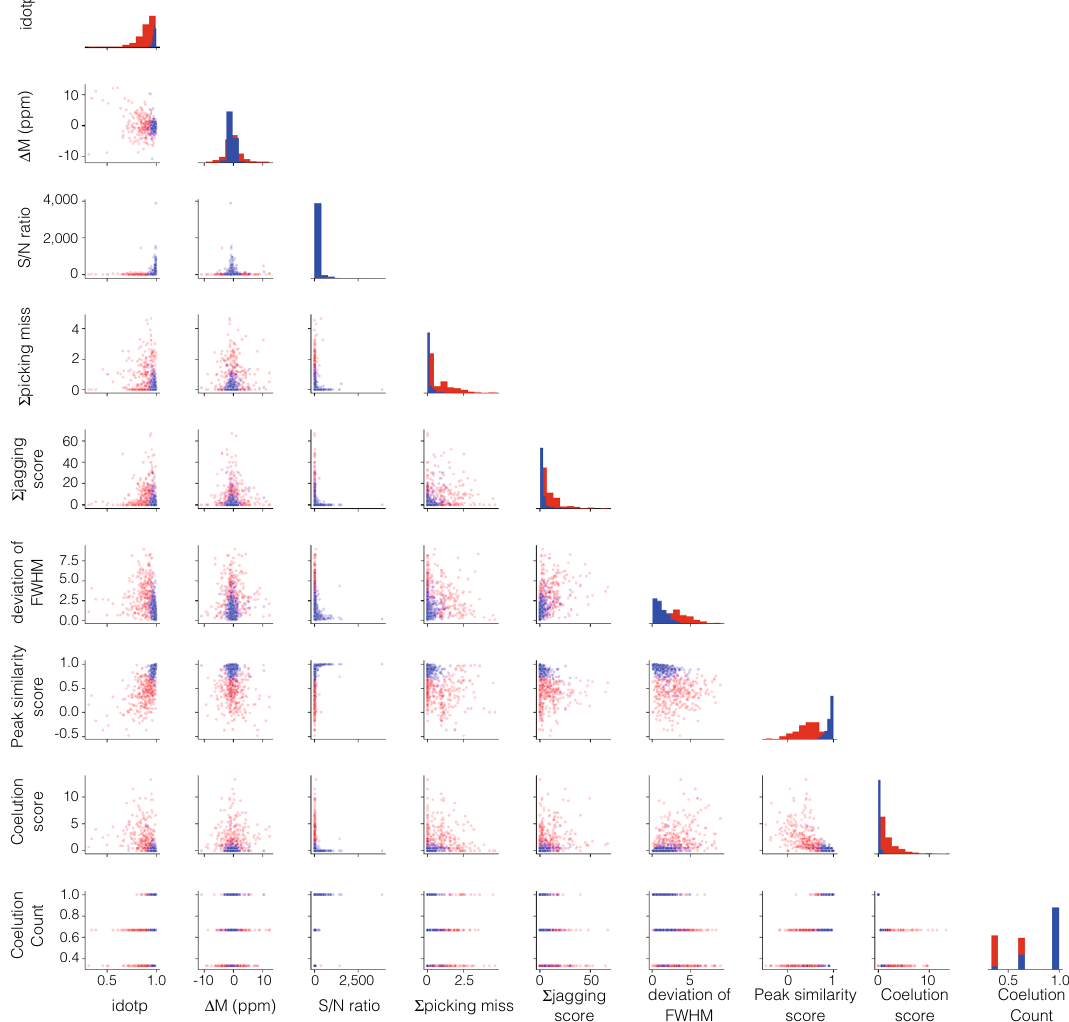
Figure 2. Correlations between chromatographic features. Correlations between combinations of two features among nine total features are shown. Peptide and noise peaks are depicted in blue and red,